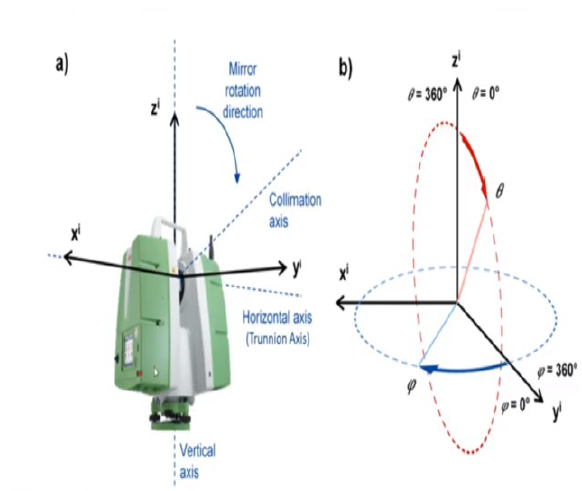
Figure 6. Terrestrial Laser Scanning Axes with their respective